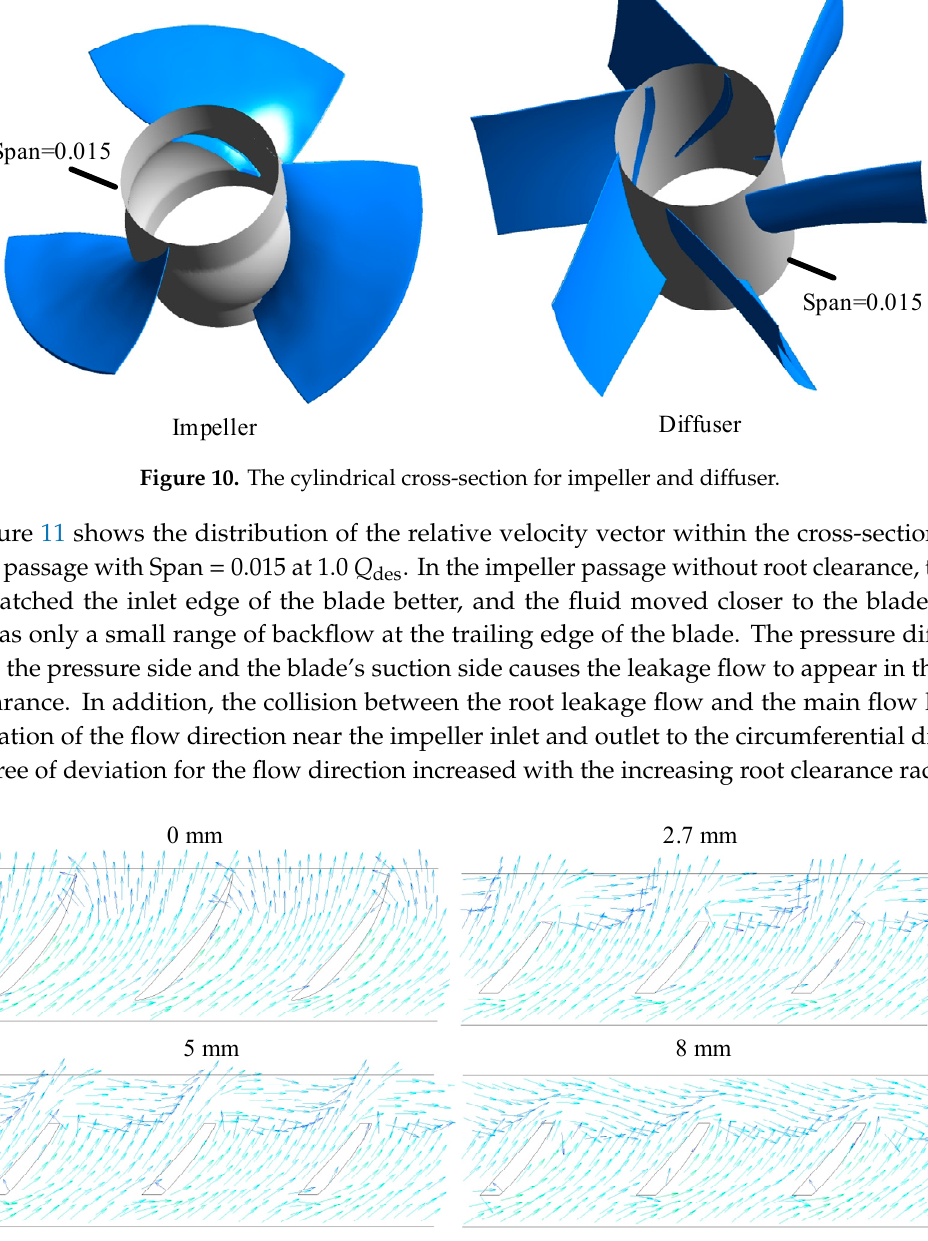
Figure 11. Distribution of velocity vector at Span = 0.015 in impeller passage with varying root clearances (R t = 0 mm, 2.7 mm, 5 mm 8 mm; Q = 1.0 Q des ).